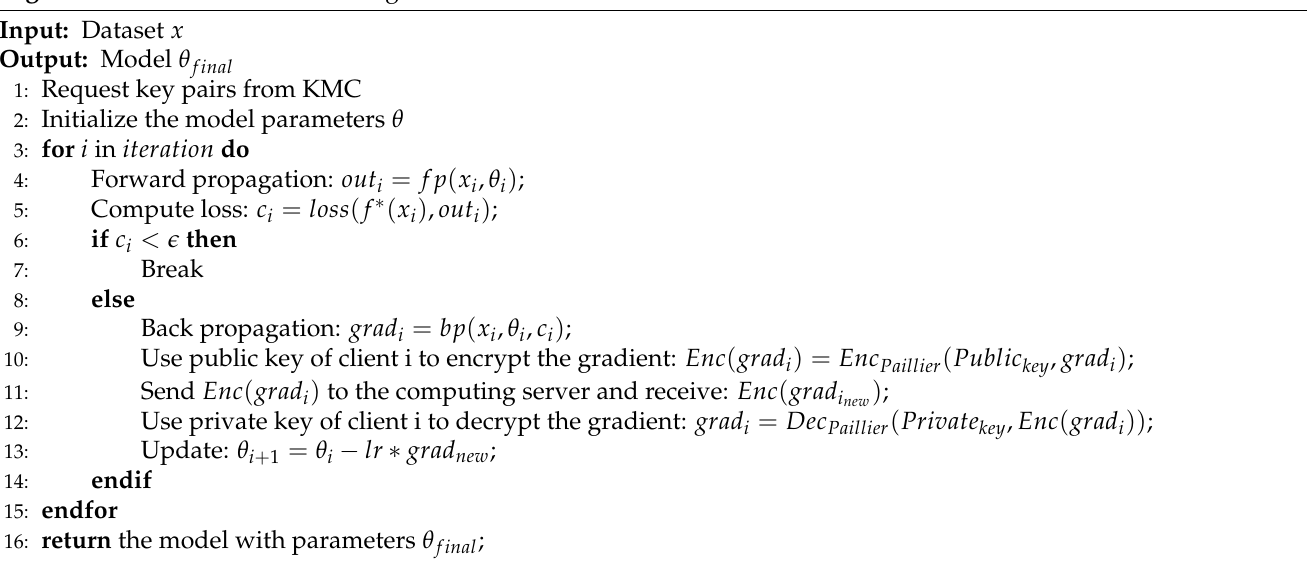
Algorithm 2 PFMLP in the Learning